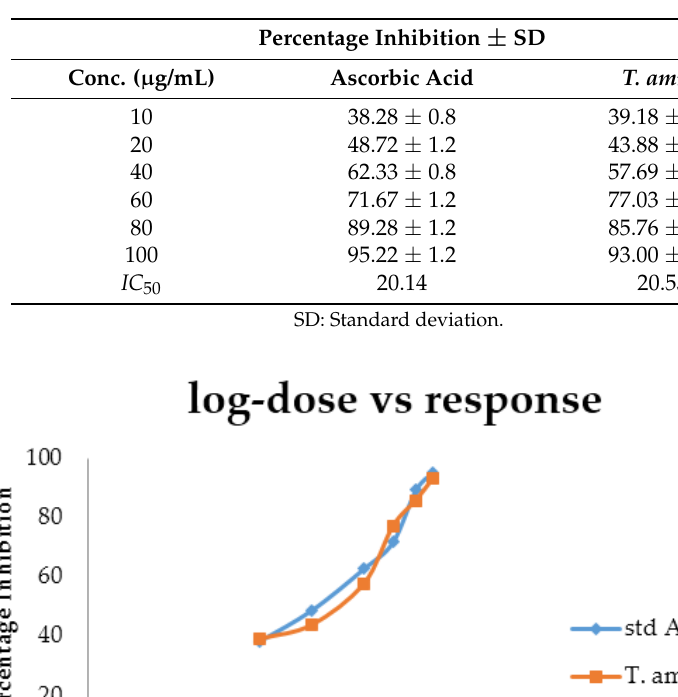
Figure 7. Comparative dose response curve between percent inhibitions against log concentration by the DPPH method. Table 8. Summary of % inhibition and IC 50 values of the T. ammi oil sample by the superoxide anion scavenging method ( n = 3).